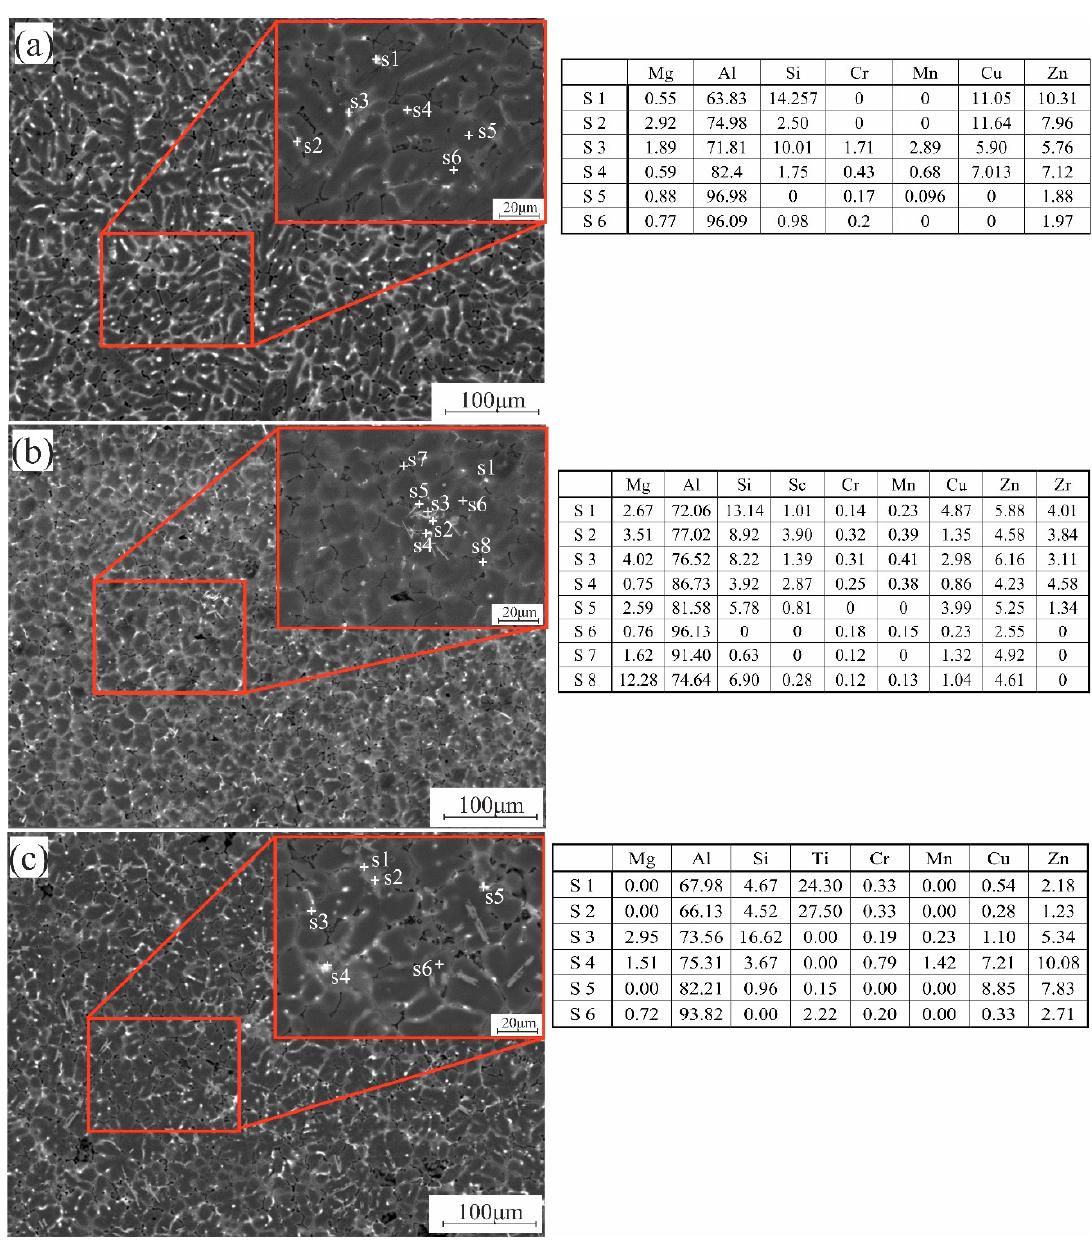
Figure 3. SEM micrographs and EDS analysis for the formed phases of the as-casted samples; ( a ) 7075-4%Si, ( b ) 7075-4%Si + ScZr, and ( c ) 7075-4%Si + TiB.